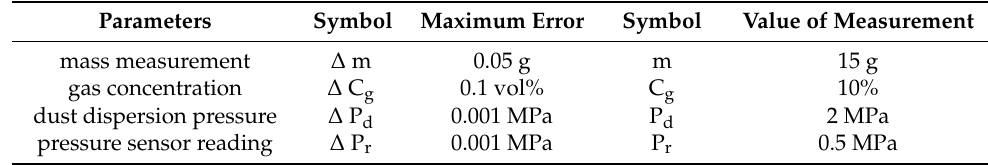
Table 1. Uncertainties, parameters, and measurement